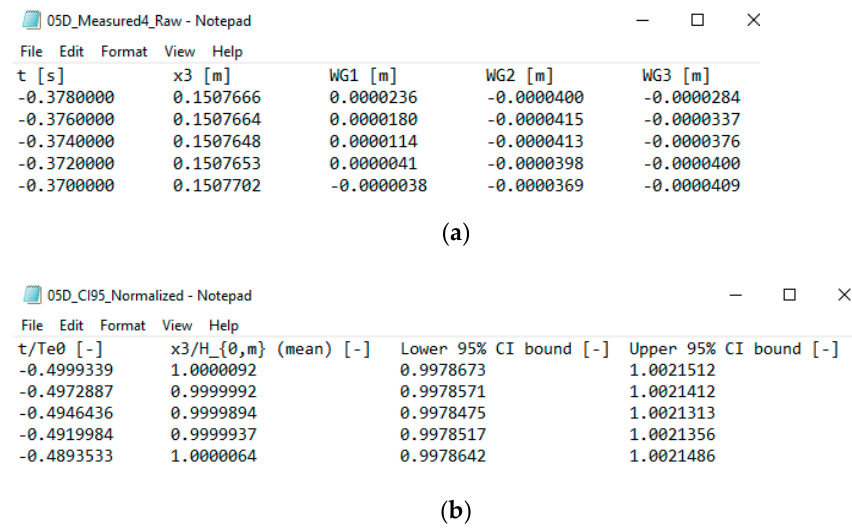
Figure A 2. Structure of result files. Example with first part of raw measurements ( a ) and mean of normalized data with 95% CI ( b ).